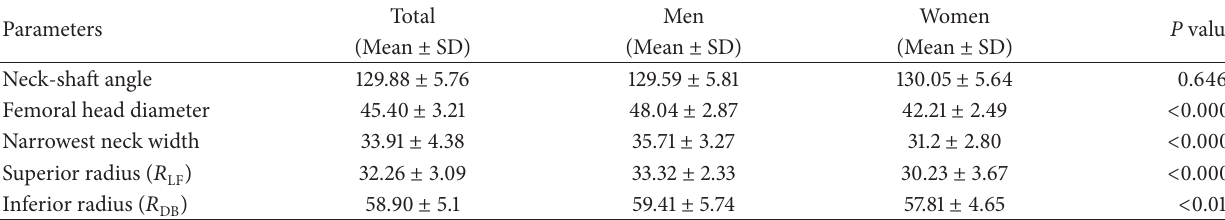
Table 2: Femoral measurements from AP view (degree; mm).